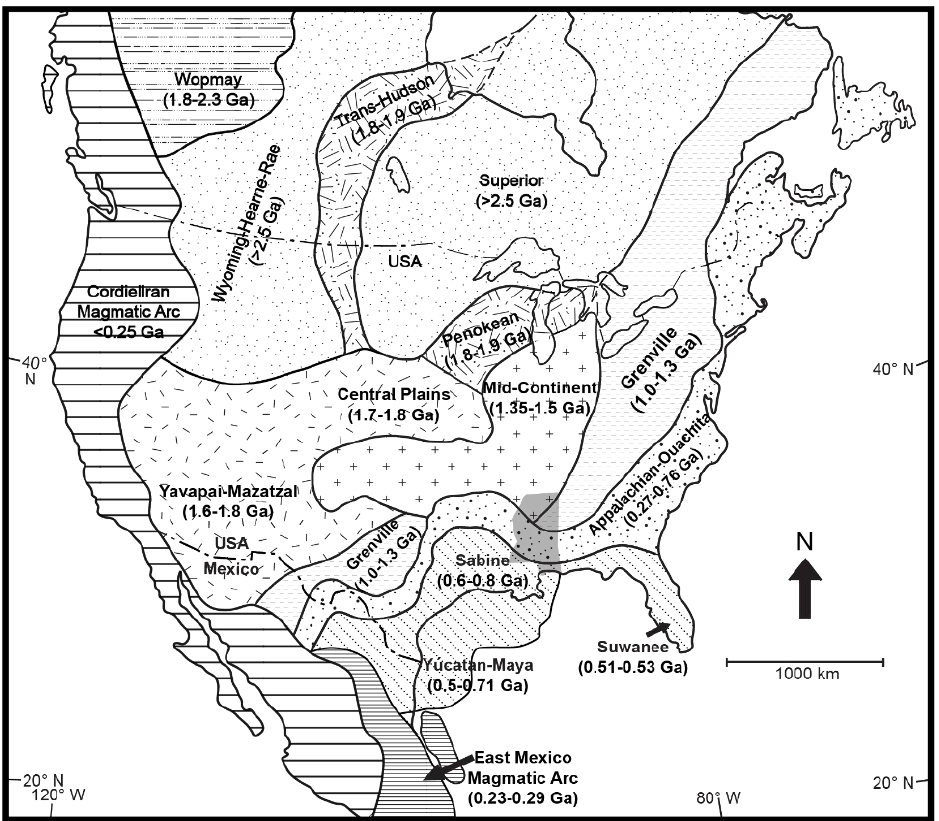
Figure 7. Igneous provinces of North America. Modified from Dickinson and Gehrels [53] and Alsalem et al. [54].